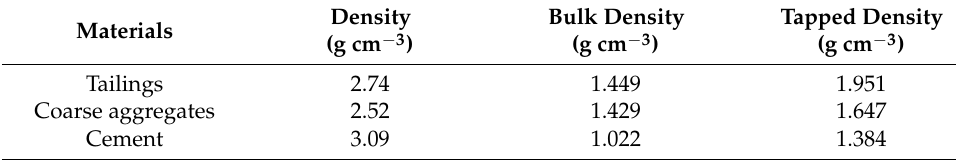
Table 1. Density, bulk density, and tapped density of solid